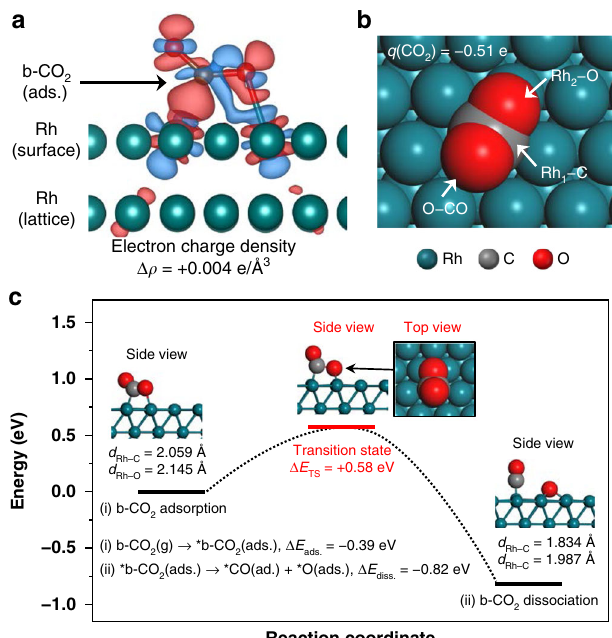
Fig. 4 Electronic interaction analysis and proposed mechanism for CO 2 dissociation. a Electron iso-surface ( ρ = 0.004 e/Å 3 ) presenting the distribution and morphology of the orbitals participating in the chemical interaction between b-CO 2 (ads.) and Rh atoms, which visualizes that each positively charged adjacent surface Rh atom is binding with C (Rh 1 − C; + 0.03 e) or O (Rh − O; + 0.17 e) atom of the b-CO 2 2 (ads.). Integrated electron charge density difference de fi ned as Δ ρ = ρ total – ρ surf – ρ adsorbate in Bader volume, where ρ total , ρ surf , and ρ adsorbate are charge density for b- CO 2 /Rh, Rh surface, and b-CO 2 molecule, respectively.